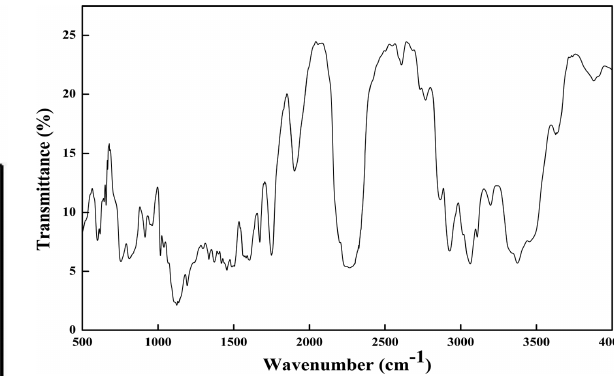
Figure 2: FTIR spectroscopy scan of the extracted resin from